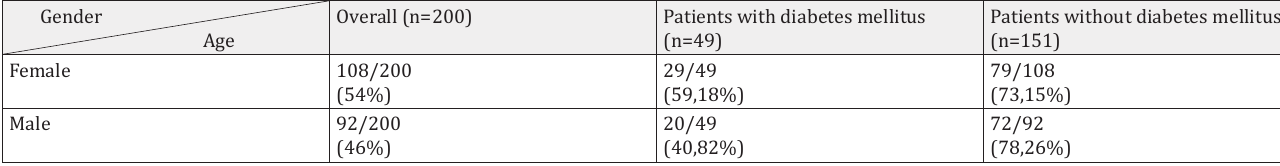
The main demographic indicators of patients